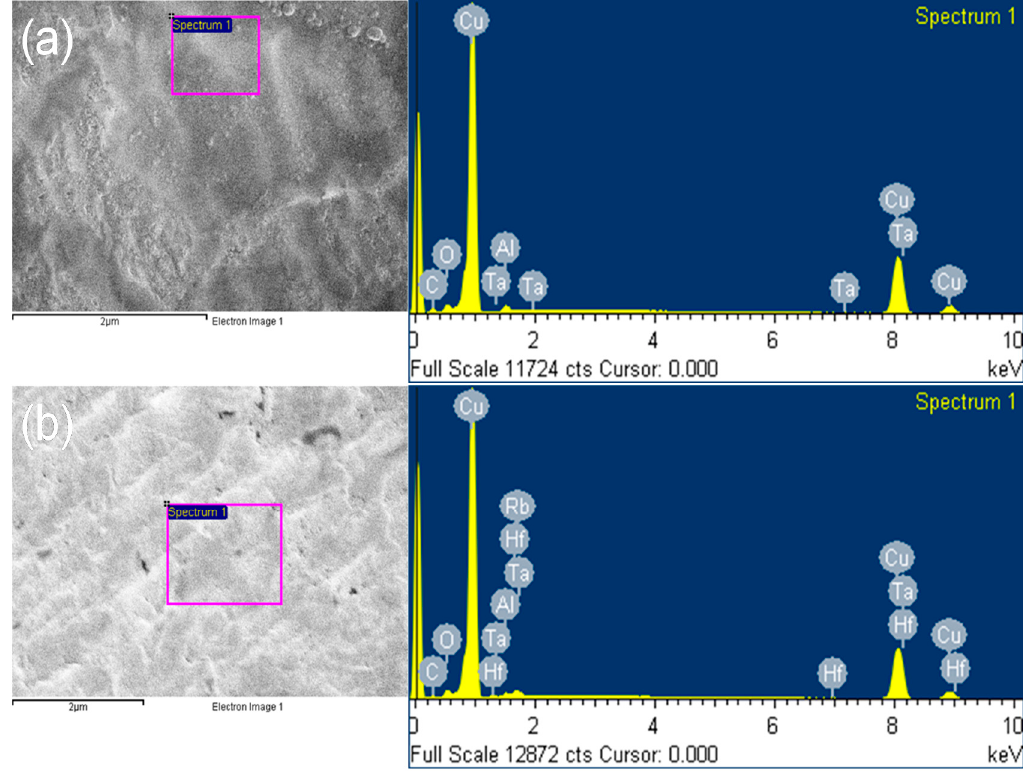
Figure 3. EDS of ( a ) alumina film and ( b ) hafnia film grown on graphene/copper foil.